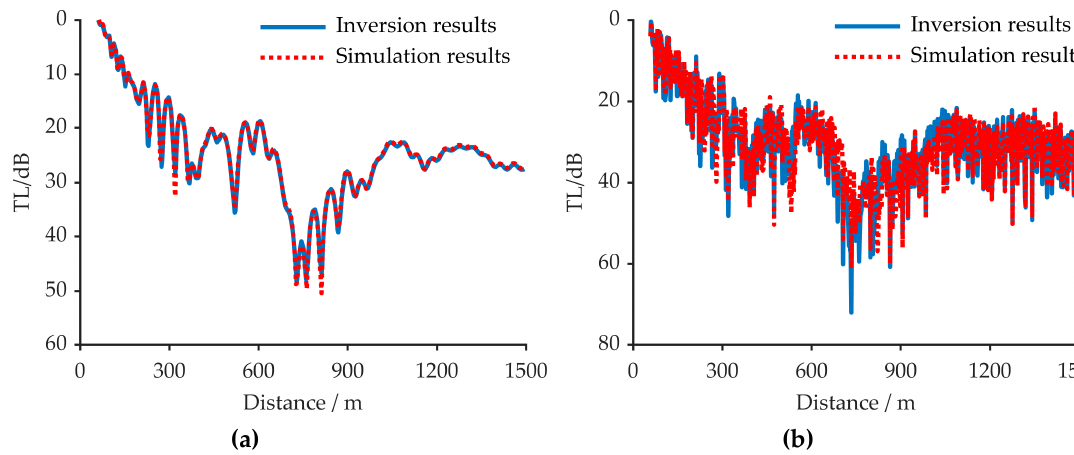
Figure 10. The verification of simulation results. The solid blue line means the Transmission Loss (TL) measured in the simulation and the dashed red line represents the TL simulated by inversion result. ( a ) the comparison of TL in the noiseless sea environment; ( b ) the comparison of TL in the noisy sea environment.